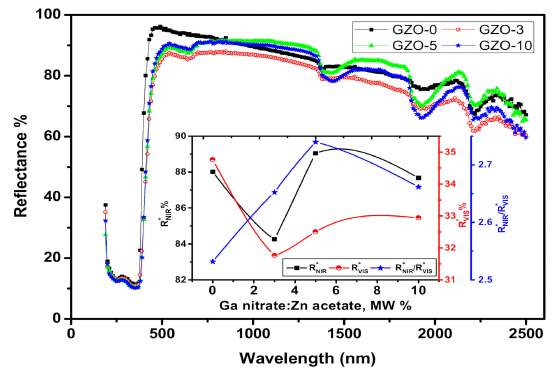
Figure 7. UV / vis / NIR di ff use reflectance spectra of the investigated Ga-doped ZnO nanopigments. The inset represents the variation of R ∗ weight